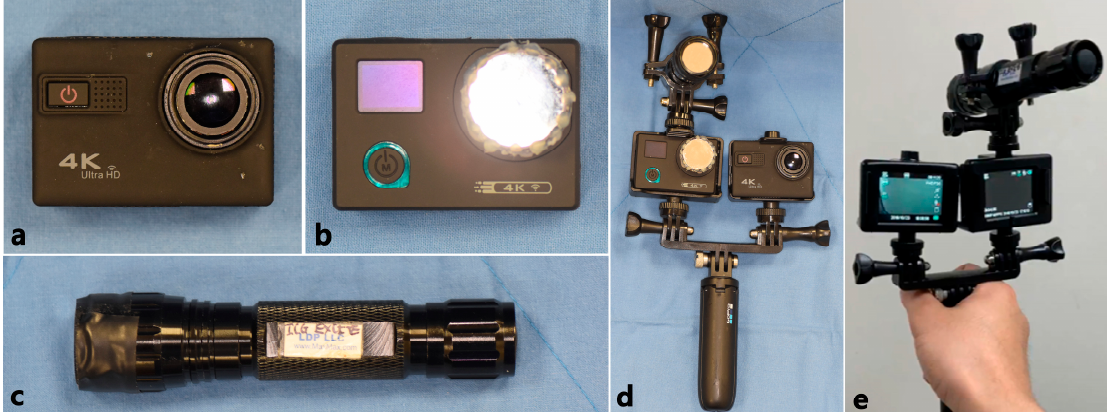
Figure 4. ICG-NIRF prototype and its components. ( a ) Modified action camera with 7.2 mm lens, ( b ) modified action camera with 7.2 mm lens and band-pass filter, ( c ) modified LED light with band-pass filter, ( d ) front of ICG-NIRF prototype, ( e ) back of ICG-NIRF prototype.